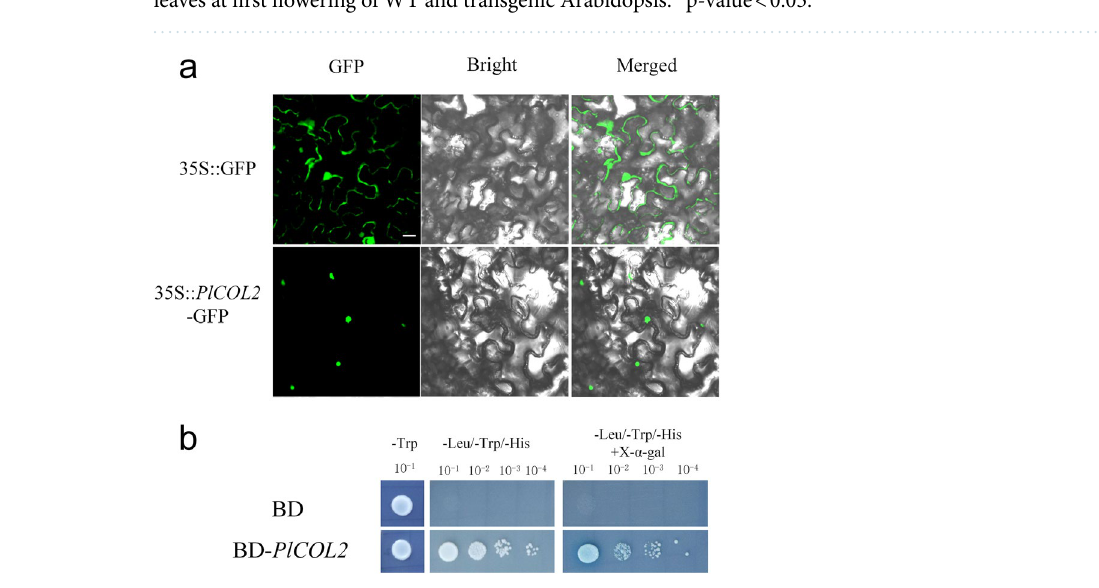
Figure 7. Subcellular localization and transcription activity ability of PlCO. ( a ) Subcellular localization of PlCO in tobacco leaves, Bar = 20 µm. ( b ) Transcription activation ability of PlCO in